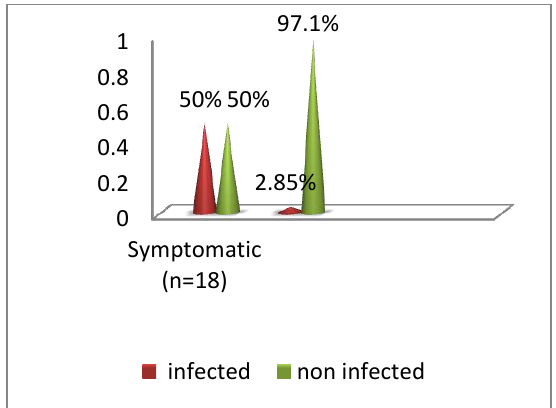
Figure-3- Association of Blastocystis spp. infection with diarrhea in patients